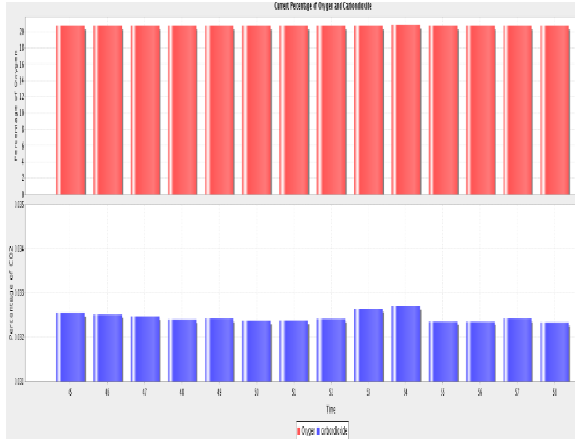
Figure 9. Visualization of percentage of oxygen and carbon-dioxide for a period of time (past